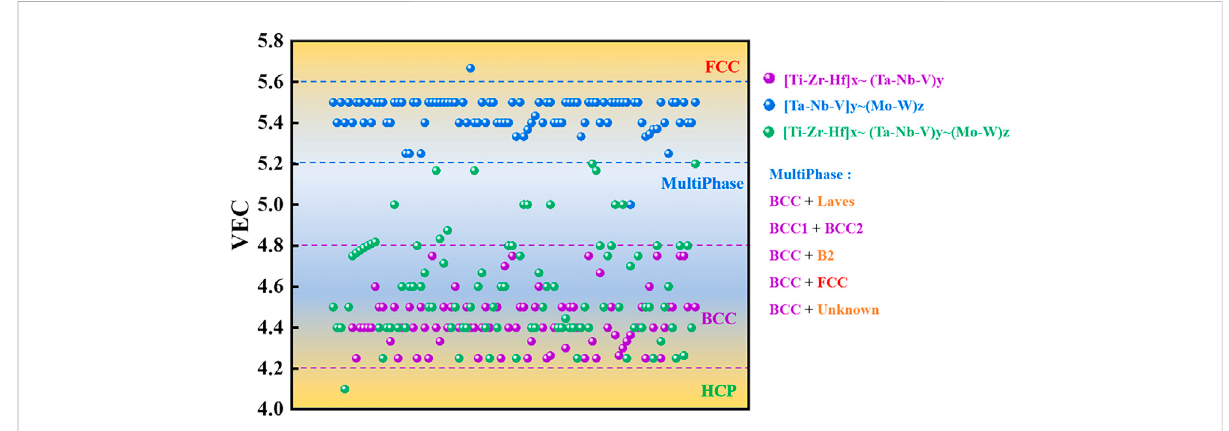
FIGURE 7 Statistical correspondence between VEC and phase composition in Bio-HEAs, Bio-HEAs are classi fi ed by [Ti-Zr-Hf] x ~ (Ta-Nb-V) y [Ti-Zr-Hf] x ~ (Mo-W)